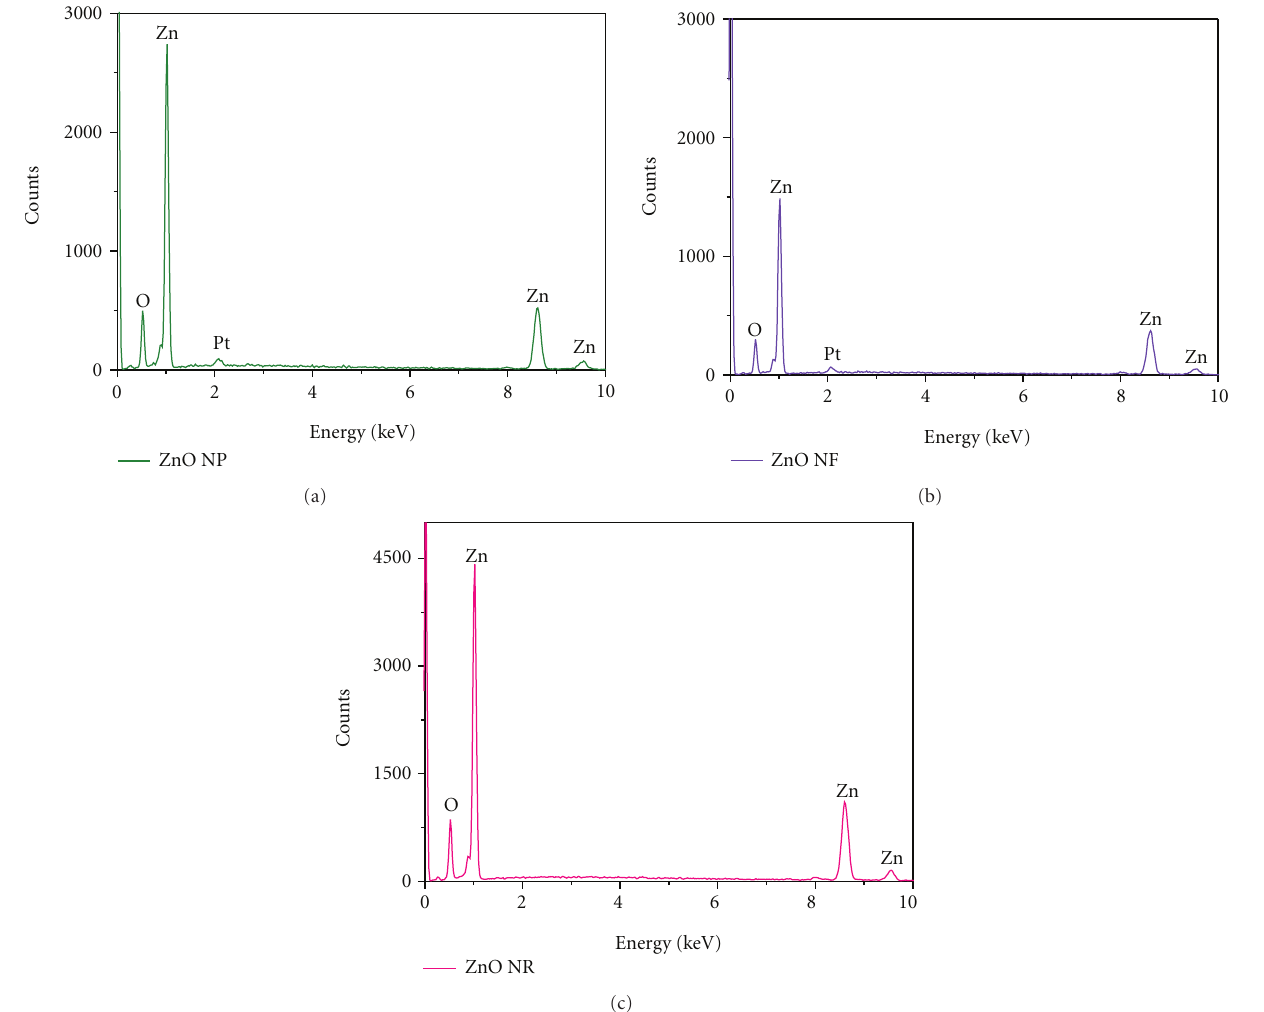
Figure 7: EDS spectra of ZnO nanoparticles (a), nanoflowers (b), and nanorods (c)